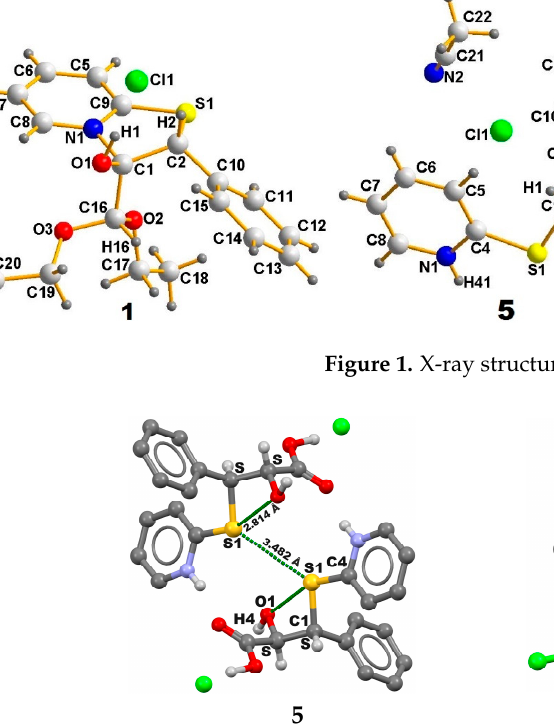
Figure 2. Inter- and intramolecular chalcogen bonds in 5 and 6 (shown as dashed green lines).